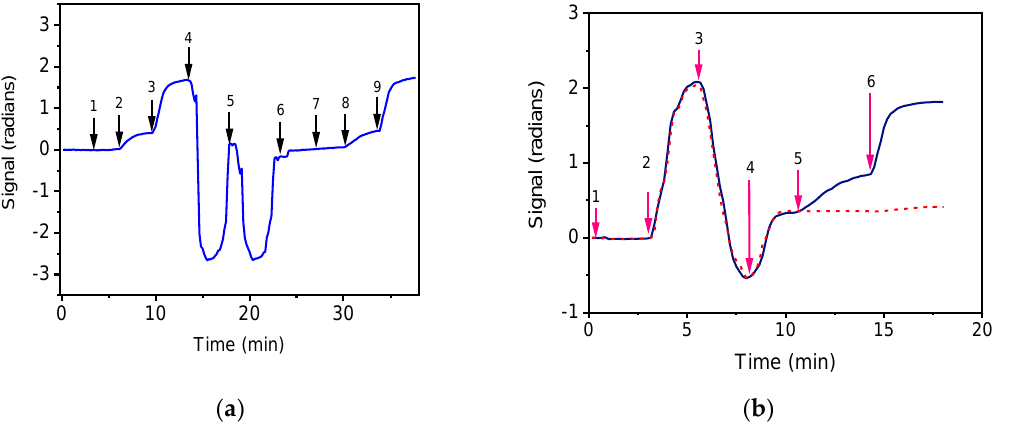
Figure 3. ( a ) Real-time response obtained for S. typhimurium zero calibrator prepared in assay buffer (arrow 1 to 4) or in bottled water (arrow 7 to end). The arrows indicate the sequence of solutions passing over the chip: assay buffer (start to 1); zero calibrator in assay buffer (arrow 1 to 2); bioti- nylated anti-species specific antibody (arrow 2 to 3); streptavidin (arrow 3 to 4); 50 mM HCl (arrow 4 to 5); 50 mM NaOH (arrow 5 to 6); assay buffer (arrow 6 to 7); zero calibrator in bottled water (arrow 7 to 8); biotinylated anti-species specific antibody (arrow 8 to 9); streptavidin (arrow 9 to end). ( b ) Real-time response obtained for E. coli zero calibrator prepared in milk. The arrows indicate the sequence of solutions passing over the chip: assay buffer (arrow 1 to 2), zero calibrator prepared in milk (arrow 2 to 3), washing buffer (arrow 3 to 4), assay buffer (arrow 4 to 5), biotinylated anti- species-specific antibody (arrow 5 to 6) and streptavidin (arrow 6 to end). Dashed line